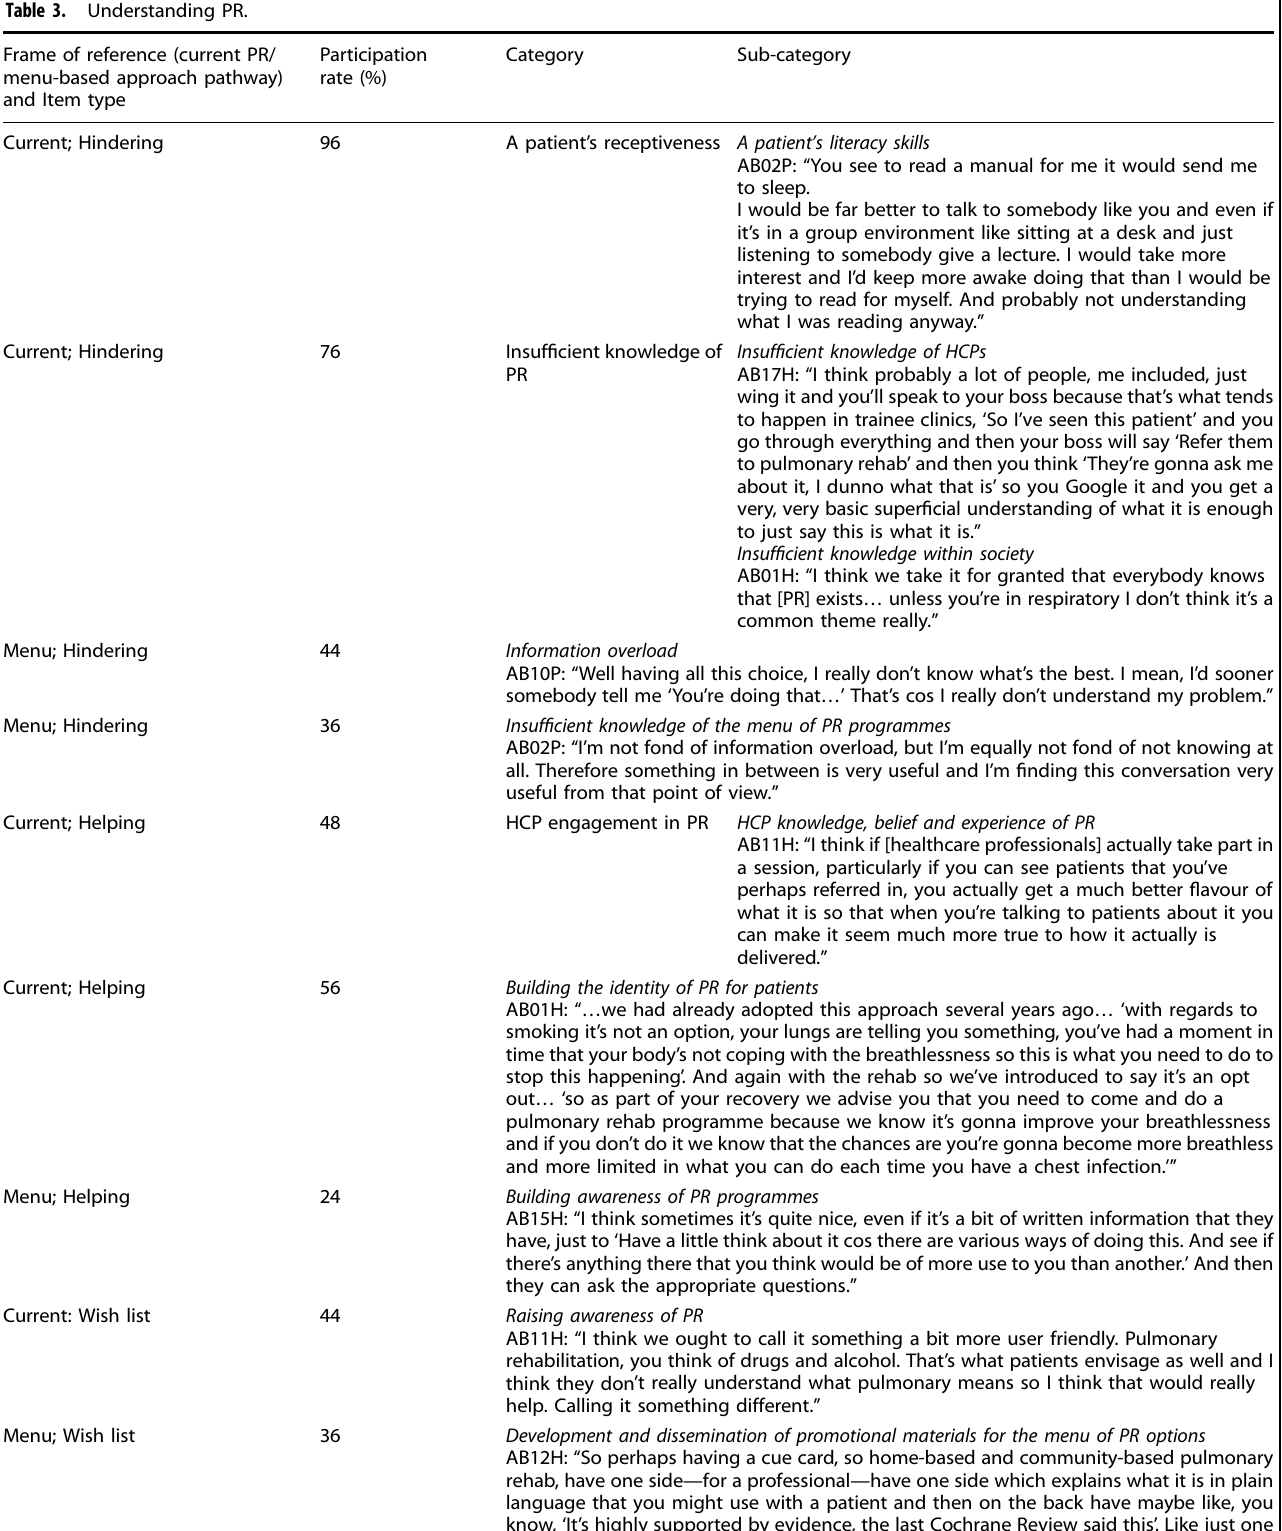
Table 3. Understanding